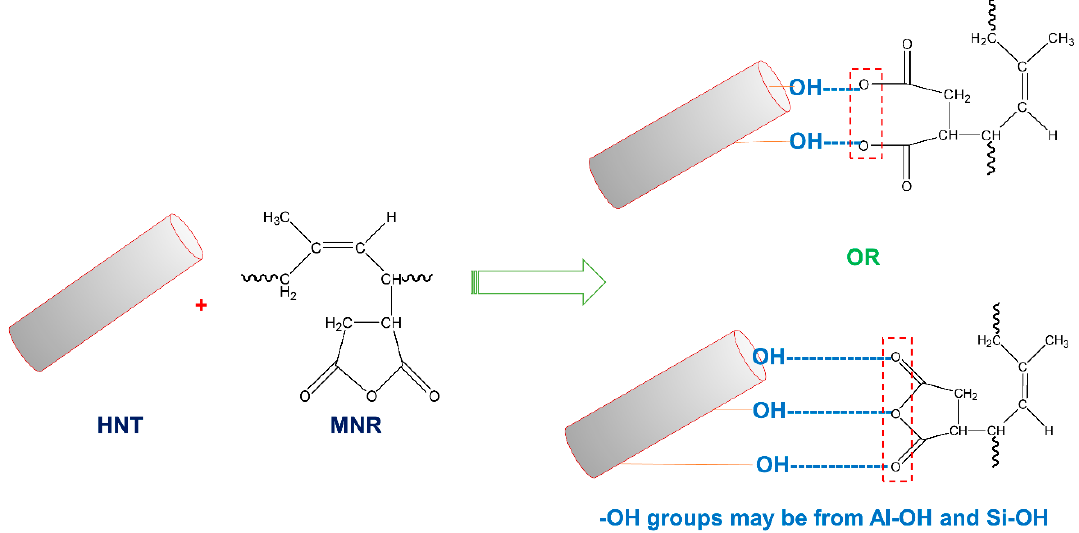
Figure 6. Possible interactions between MNR and HNT.